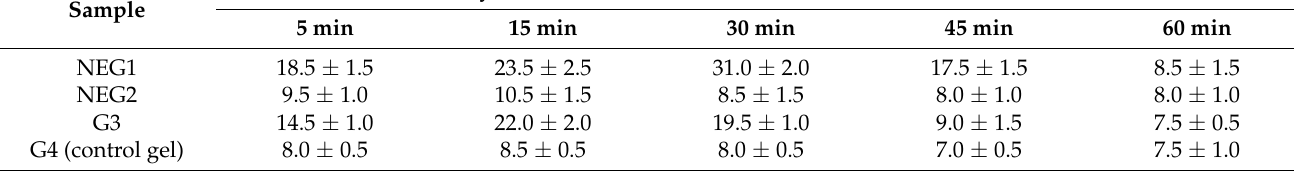
Table 5. Results of in vivo local anesthetic activity on rats using HPC hydrogel loaded with optimized CO-NE (NEG1), HPC hydrogel loaded with NE formulated with oleic acid instead of CO (NEG2), aqueous dispersion of CO-NE without HPC gel base (G3), and plain HPC hydrogel (G4).